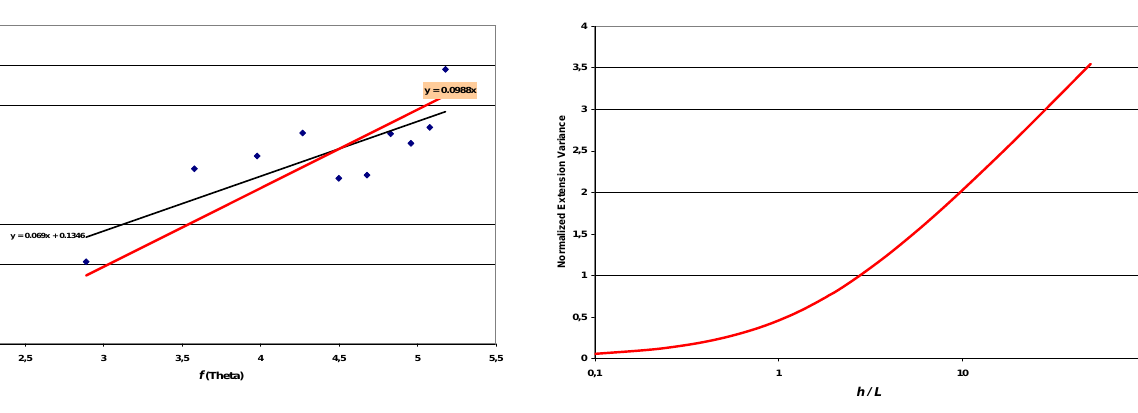
Fig. 8. Straight line (red) for Pulacayo zinc values fitted by con- strained least squares to 10 variogram values taken from Math- eron (1964). Horizontal axis is for f ( θ ). Line was forced through the point where f ( θ ) = 0 and h = 0 (cf. Eq. 4). Its slope β = 0.0988 yields estimate of absolute dispersion α( = 0.0165). Best-fitting line without constraint (black), that is significantly different, is shown for comparison.